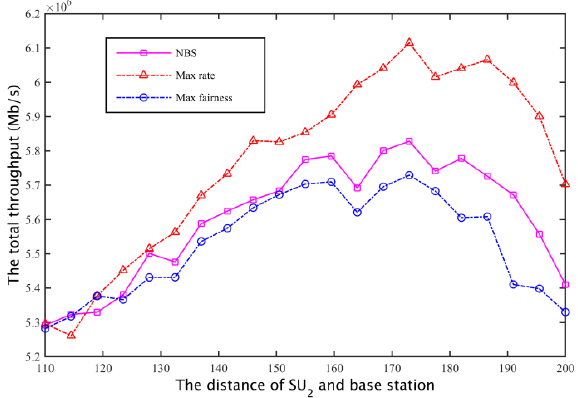
Figure 23. The comparison of total throughput for the secondary network II.